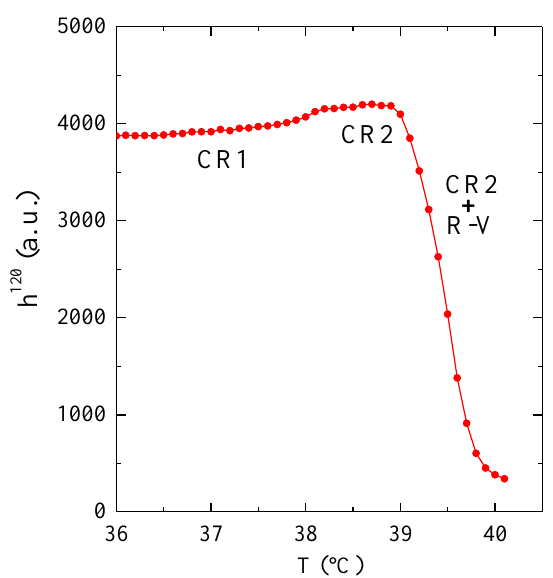
Figure 5. Dependence on temperature of peak height for the diffraction (120) in the vicinity of the δ transition (from CR1 to CR2) for sample C 23 H 48 .